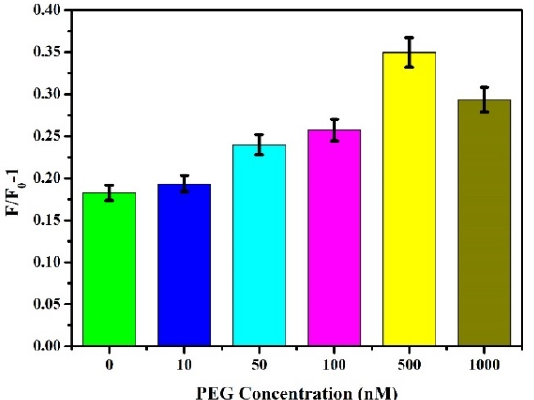
Figure 8. Effect of PEG with different concentrations on fluorescence intensity.